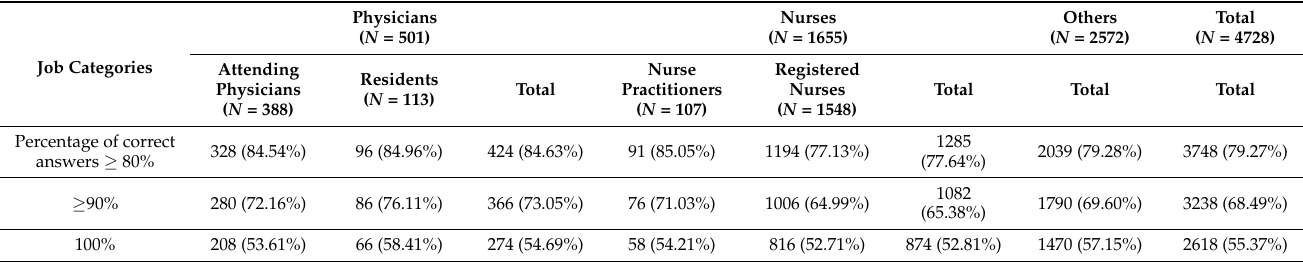
Table 3. Percentage of passing rate of the ten COVID-19 multiple-choice questions with different cut-off scores of different healthcare workers in the pre-test.